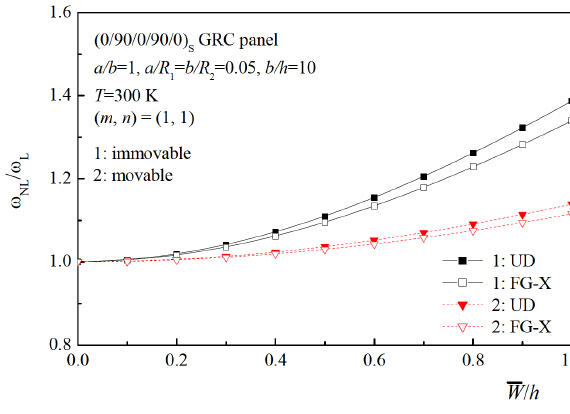
Figure 7: Influence of in-plane boundary conditions on the frequency-amplitude curves of doubly curved (0/90/0/90/0) S GRC laminated panels